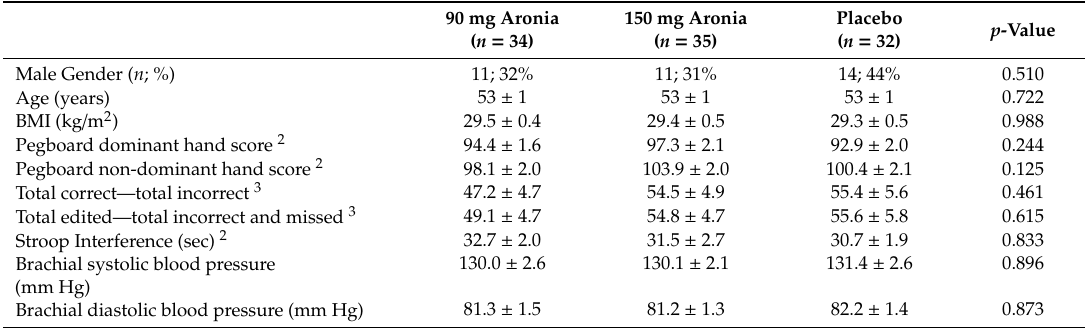
Table 1. Demographics of participants in the three experimental groups at baseline 1